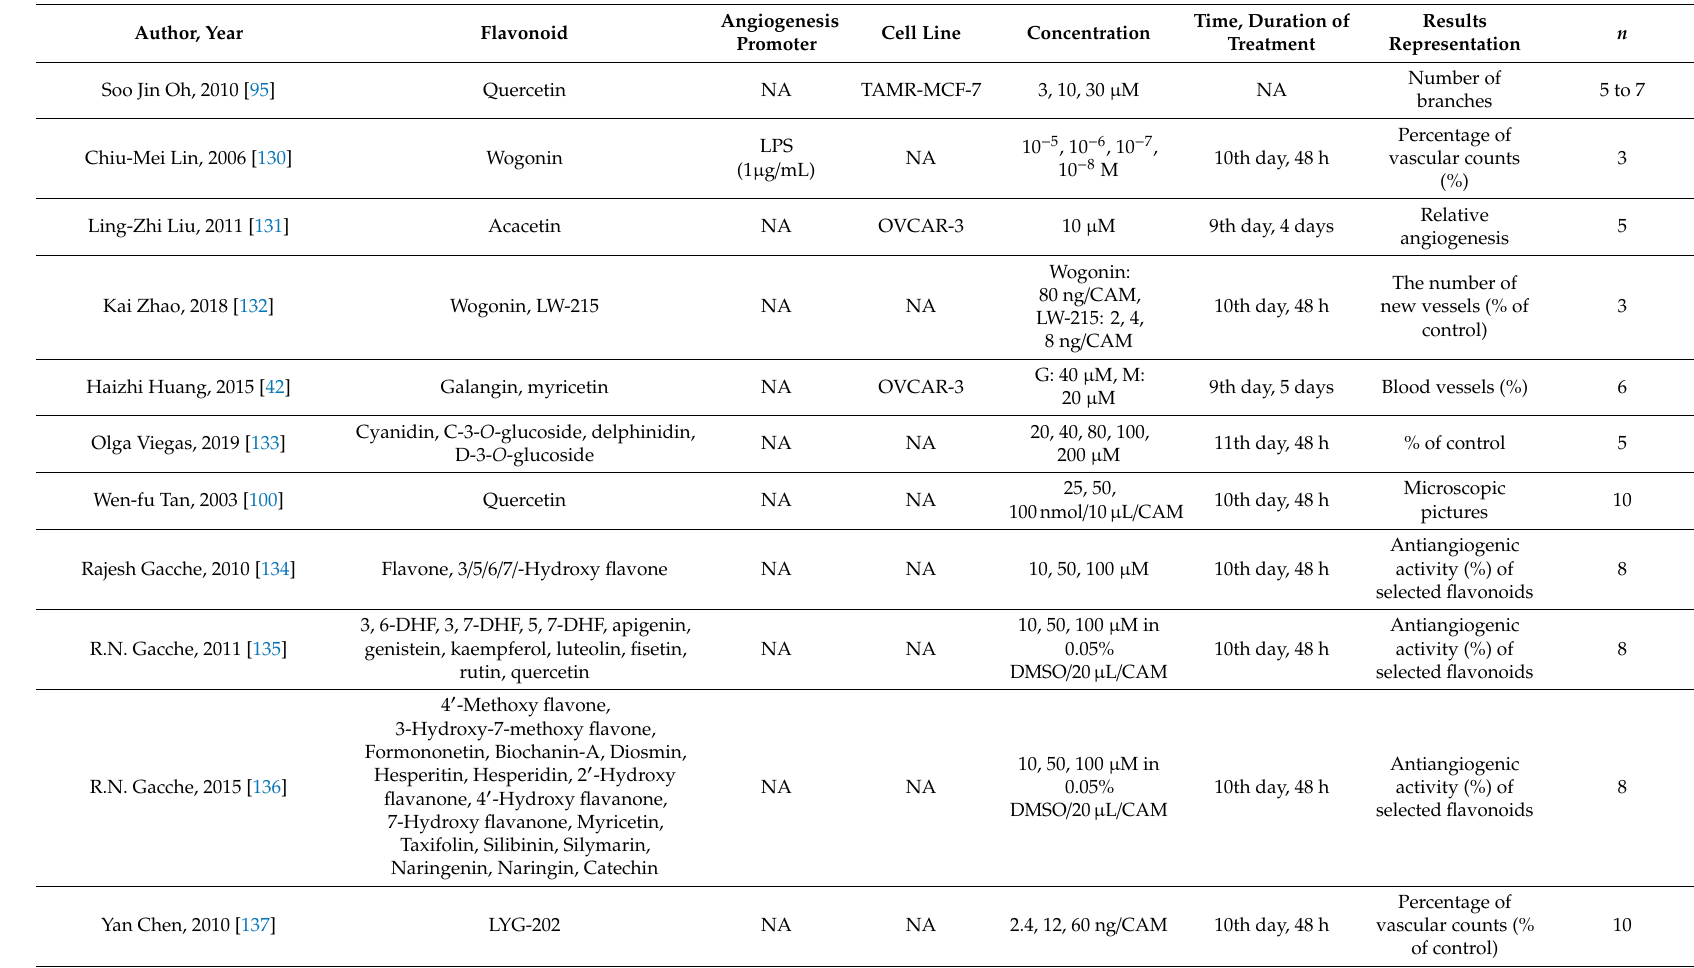
Table 2. Characteristics of the studies included in Section